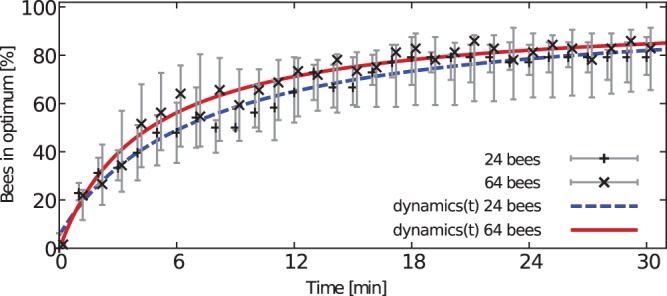
Aggregation process over time.The graph shows the decision making process over the whole experimental time of 30 minutes. Depicted is the percentage of bees (median and quartiles) in the optimum for groups of 24 and 64 bees. The curves were fitted according to the saturation function .